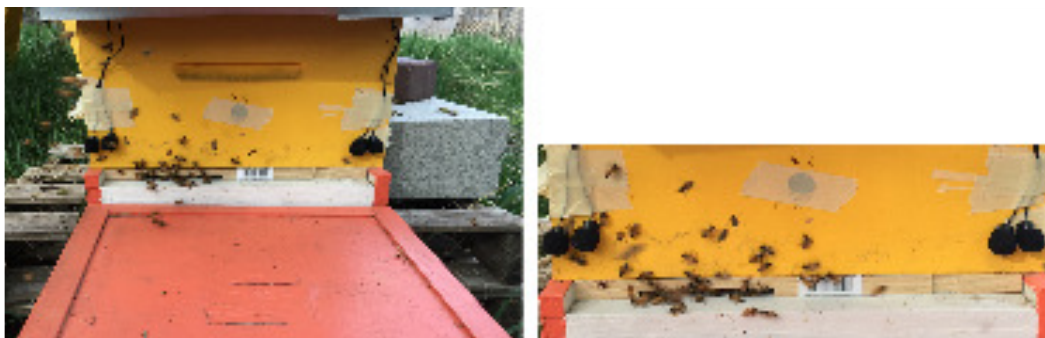
Figure 1. Four Neewer lapel microphones above Langstroth landing pad. The four microphones (two on each side of the pad) are placed approximately 10 cm above the Langstroth landing pad; four microphones are connected to the microphone hub inside the box with the BeePi hardware components placed on top of the hive; the microphones are not affected by rain or